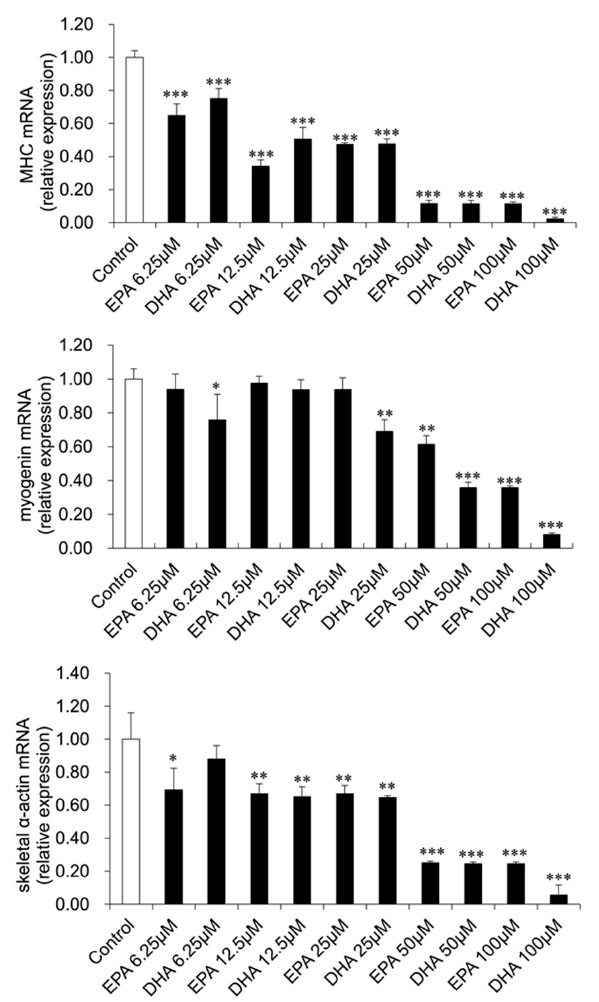
Figure 2. The effects of EPA and DHA on the mRNA expressions of the myogenic marker genes in C2C12 myoblasts. C2C12 myoblasts were cultured in differentiation medium with various concentrations of EPA or DHA for 48 h. qRT-PCR was performed to examine the mRNA expression levels of MHC, myogenin and skeletal α -actin. The data represent the mean ± S.D. from three independent experiments performed in duplicate. Different from control, * p < 0.05, ** p < 0.01 and *** p < 0.001.